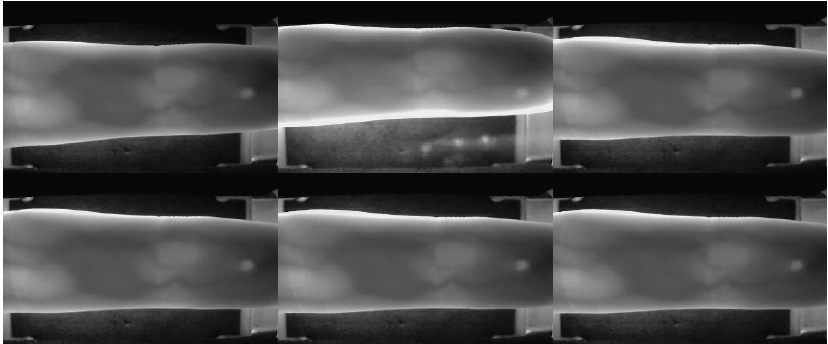
Figure 4. The sample images of SDUMLA-HMT Finger Vein Dataset. University of Twente Finger Vascular Pattern (UTFVP) dataset is the second dataset used for experimental evaluation. The dataset was collected from 60 individuals with 73% male, 87% right-handed, and 82% aged 19–30 at Twente University [17]. The finger vein images were captured with a local custom device. Each individual provides the index, middle, and ring finger of both hands, and each finger is sampled four times. In total, there are 1440 (60 individuals × 3 fingers × 2 hands × 4 samples) images in the dataset. Each of them is in a “png” format with 672 × 380 pixels in size. The samples of finger vein images from UTFVP can be seen in Figure 5. Figure 5. The sample images of UTFVP Finger Vein Dataset. For the subsequent experimental analysis purpose, the following conventions are used: li stands for the left index finger, lm stands for the left middle finger, lr stands for the left ring finger, linear1 stands for linear SVM matching without optimization, linear2 stands for linear SVM matching with optimization, while rbf1 stands for RBF SVM match- ing without optimization, rbf2 stands for RBF SVM matching with optimization, BSSF stands for Bayesian optimized SVM score fusion, and BSBF stands for Bayesian optimized SVM based fusion. Equal error rate (EER) is used as the performance measurement of the proposed methods. EER is the rate at which the false acceptance rate and false rejection rate are (almost) equal. In this work, linear1 and rbf1 are used to serve as a baseline score level fusion method for comparison purpose. The proposed system is tested with stratified three-fold cross-validation to ensure the validity of the system. The optimization of the hyperparameters is also done with the cross-validation using a different random seed from the test cross-validation to prevent overfitting to the test cross-validation [18]. 5.2. Performance Analysis of Multi-Instance Feature Descriptors Biometrics The proposed system uses the Bayesian optimization approach to search for an opti- mal set of hyperparameters of the histogram of oriented gradients (HOG). The hyperpa- rameters are: orientations , pixels , cells , norm , and transform_sqrt . Orientations is the number